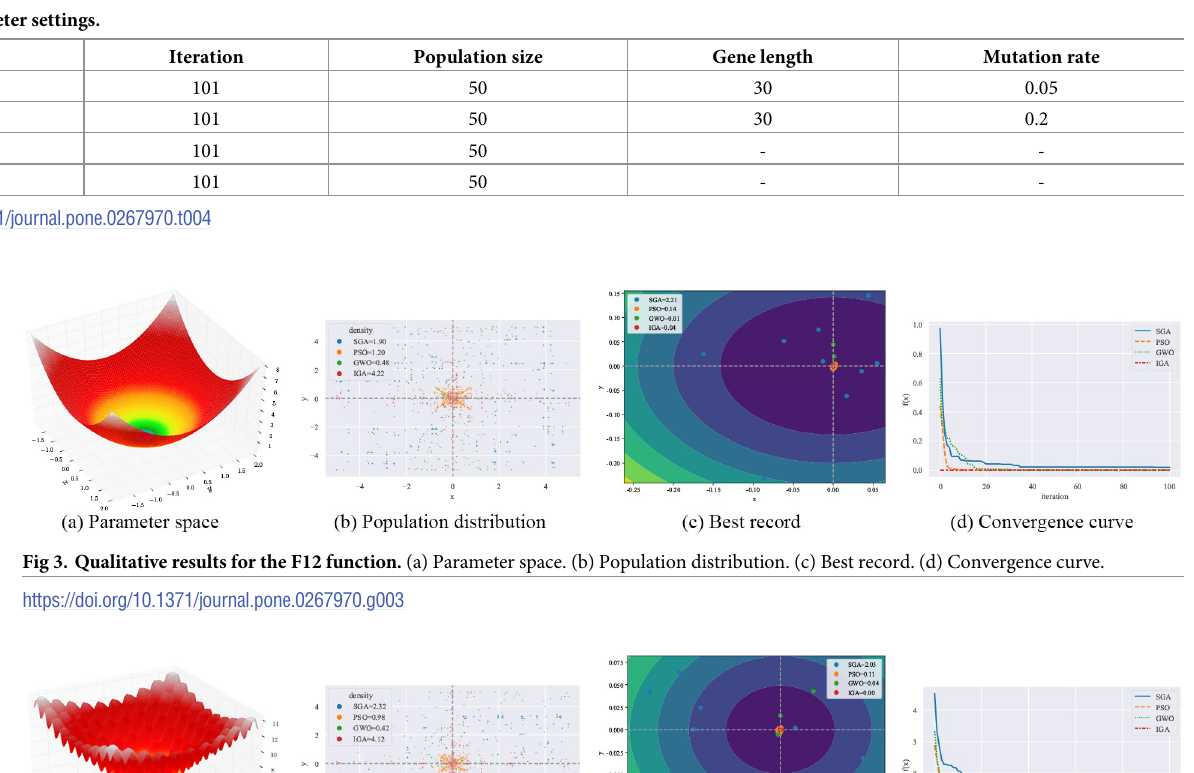
under the same experimental conditions. Among them, “Population distribution” is the scatter plot of the distribution of all individuals for each optimization algorithm in 10 experiments, and the formula for the density is shown in Formula (1), population _ size = 50. “Best record” is the scatter plot of the distribution of the optimal individuals for each experiment, and the for- mula for calculating the intensity is shown in Formula (2). From the figure, we can see that the density of optimal individuals for each round of experimental IGA is better than the other